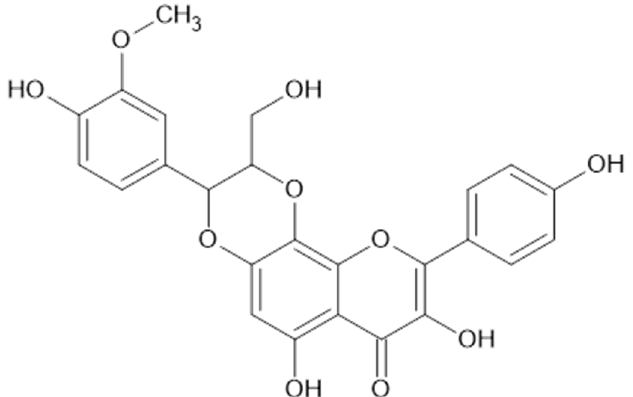
Figure 4. Rhodiolgin ( 36 , MW 464).